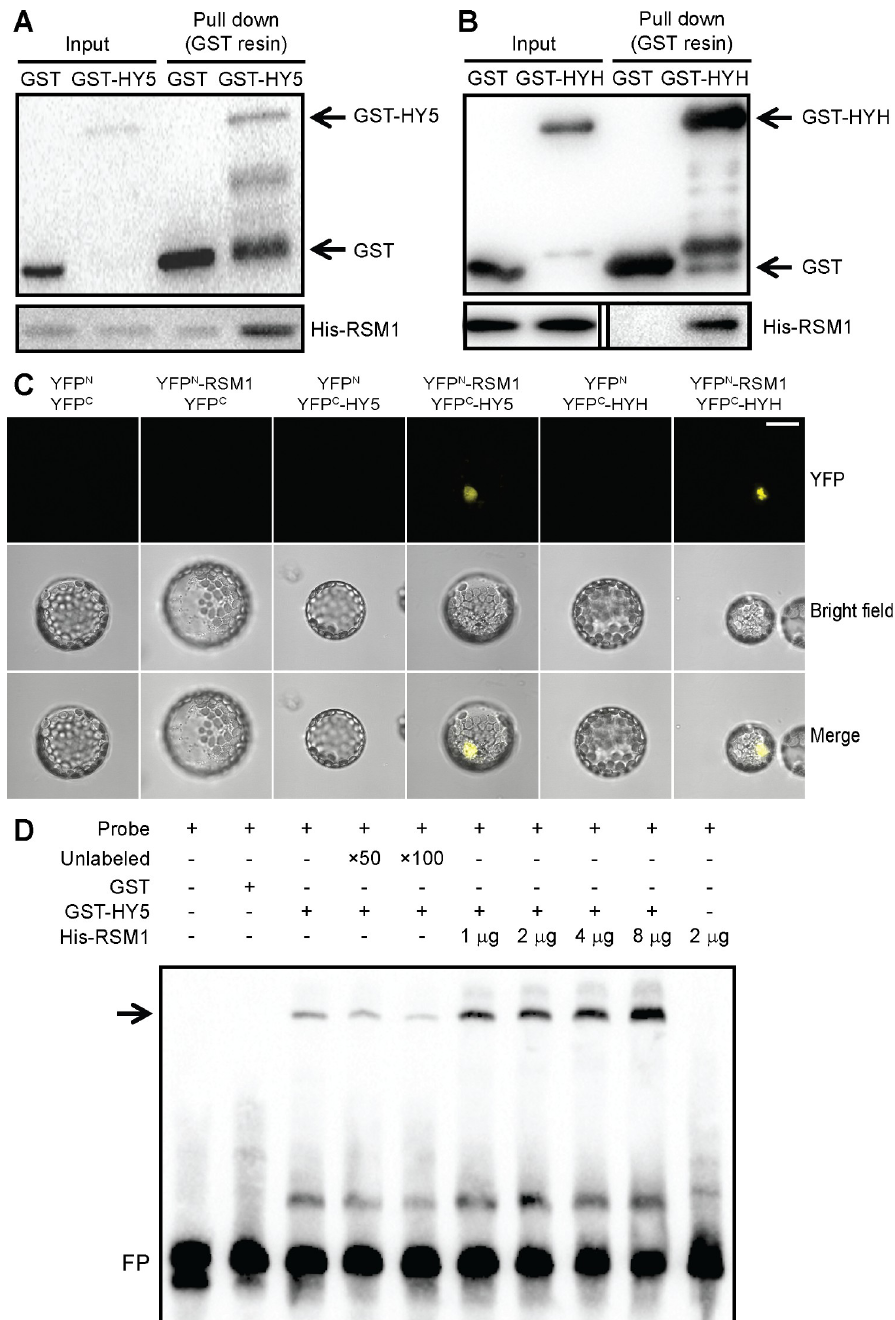
Fig 9. RSM1 interacts with HY5 and HYH in vitro and in vivo . (A) GST-HY5 and (B) GST-HYH interacted with His-RSM1 in vitro in the pull-down assay. His-RSM1 was incubated with GST or GST-HY5 (or GST-HYH) and glutathione beads at 4˚C for 2 hours, after which the precipitates were subjected to SDS PAGE and immunoblotting with anti-GST or anti-His antibody as the primary antibody. (C) RSM1 interacted with HY5 and HYH in vivo in BiFC assays in protoplasts. YFP N -RSM1 and YFP C -HY5/HYH were transiently co-transformed into Arabidopsis mesophyll cell protoplasts. After overnight incubation in the dark, the YFP signal was detected by confocal microscopy. Pairs of empty vectors (YFP N and YFP C ) and a protein fusion vector were used as negative controls. The scale bar indicates 10 μ M. (D) RSM1 affected HY5 binding to the ABI5 promoter in EMSAs. The biotin-labeled DNA probe was incubated with GST-HY5 or His-RSM1 protein. GST served as the negative protein control. Two grams of either GST or GST-HY5 protein were added to the mixture, while His-RSM1 protein was added as indicated in the figure.